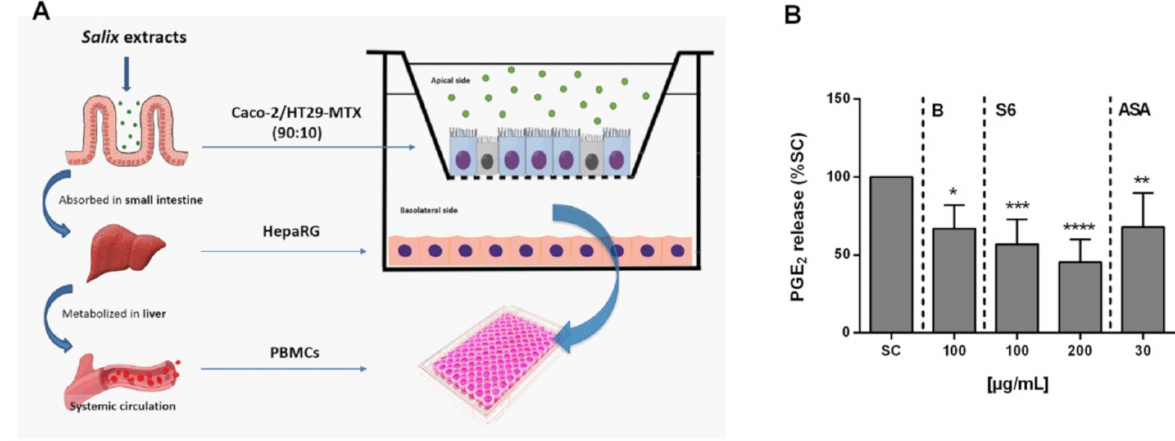
Figure 5. The anti-inflammatory effect of Salix extracts and ASA in LPS-stimulated PBMCs after intestinal absorption and liver cell metabolism. ( A ) Schematic diagram of the in vitro triple co-culture model system. ( B ) Inhibition of PGE 2 secretion from LPS-stimulated PBMCs after in vitro absorption and metabolism. After 4 h incubation of Salix extracts and ASA in the co-culture model system, the supernatant from the basolateral side was collected and immediately incubated with PBMCs (1 × 10 6 cells/mL) for 30 min before LPS (100 ng/mL) stimulation for 24 h to determine the remaining anti-inflammatory capacity. PGE 2 was quantified using an ELISA kit. SC: 1% distilled water in activated cells. Bars are the means ± SD ( n ≥ 3). * p < 0.05, ** p < 0.01, *** p < 0.001, or **** p < 0.0001 versus the SC